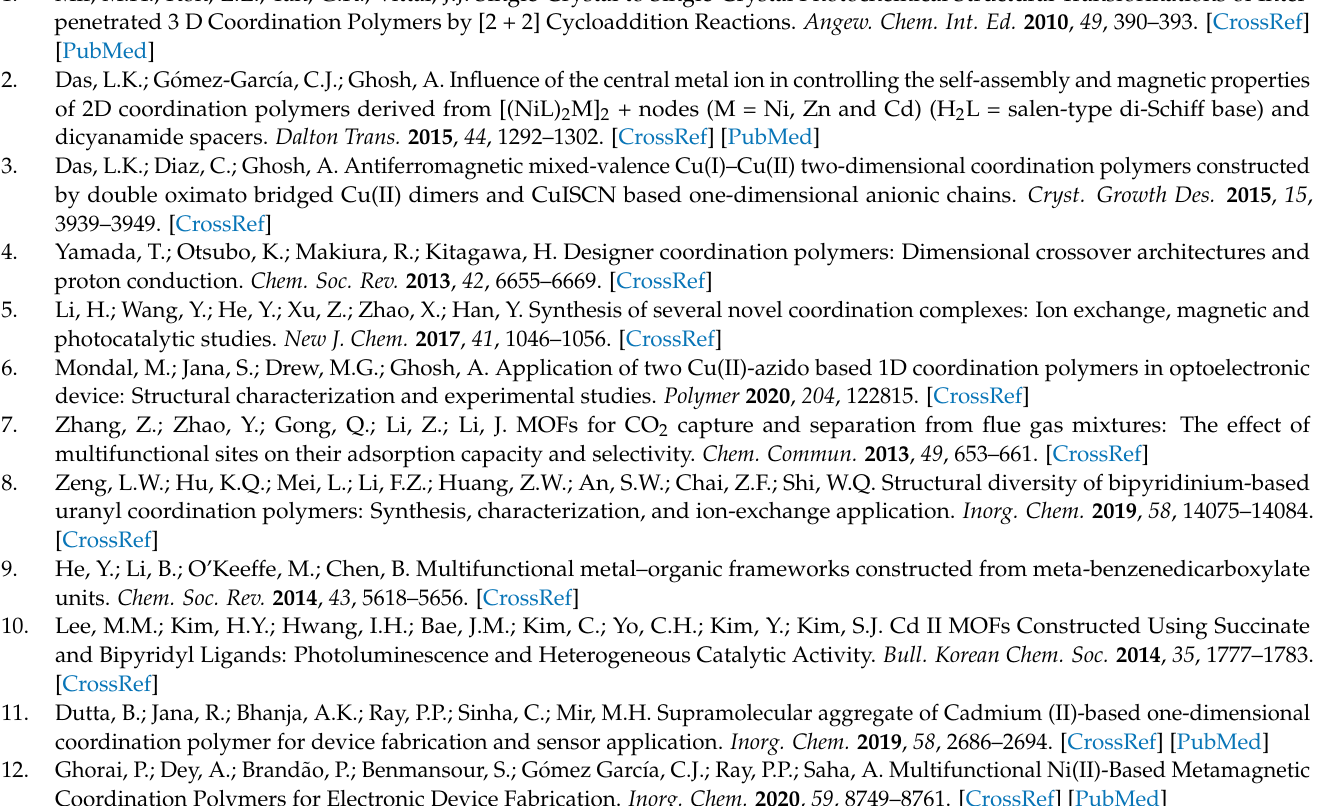
Computational details; Figure S1 Hirshfeld surfaces of 1 . Figure S2 Hirshfeld surfaces of 2